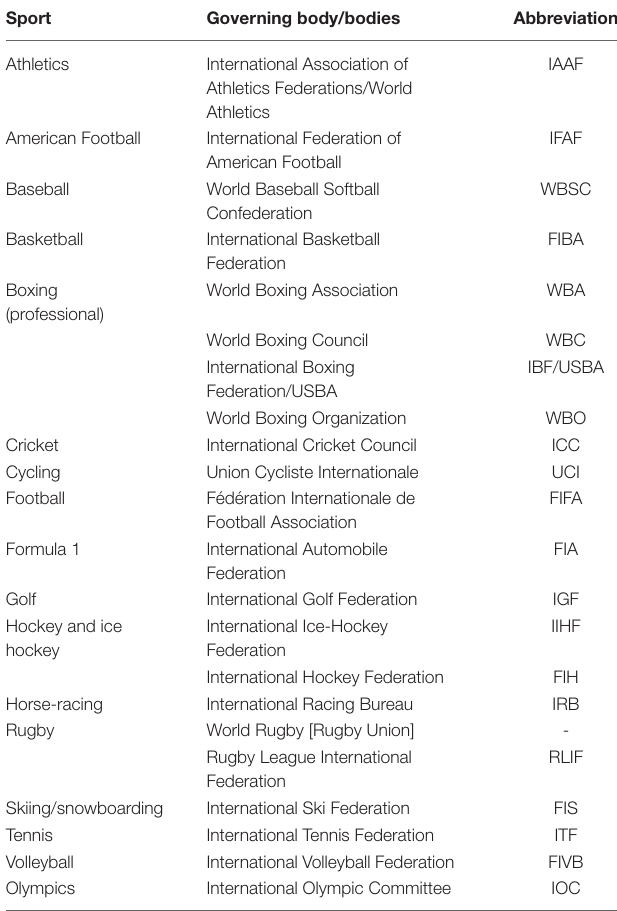
TABLE 1 | Sampled sports and